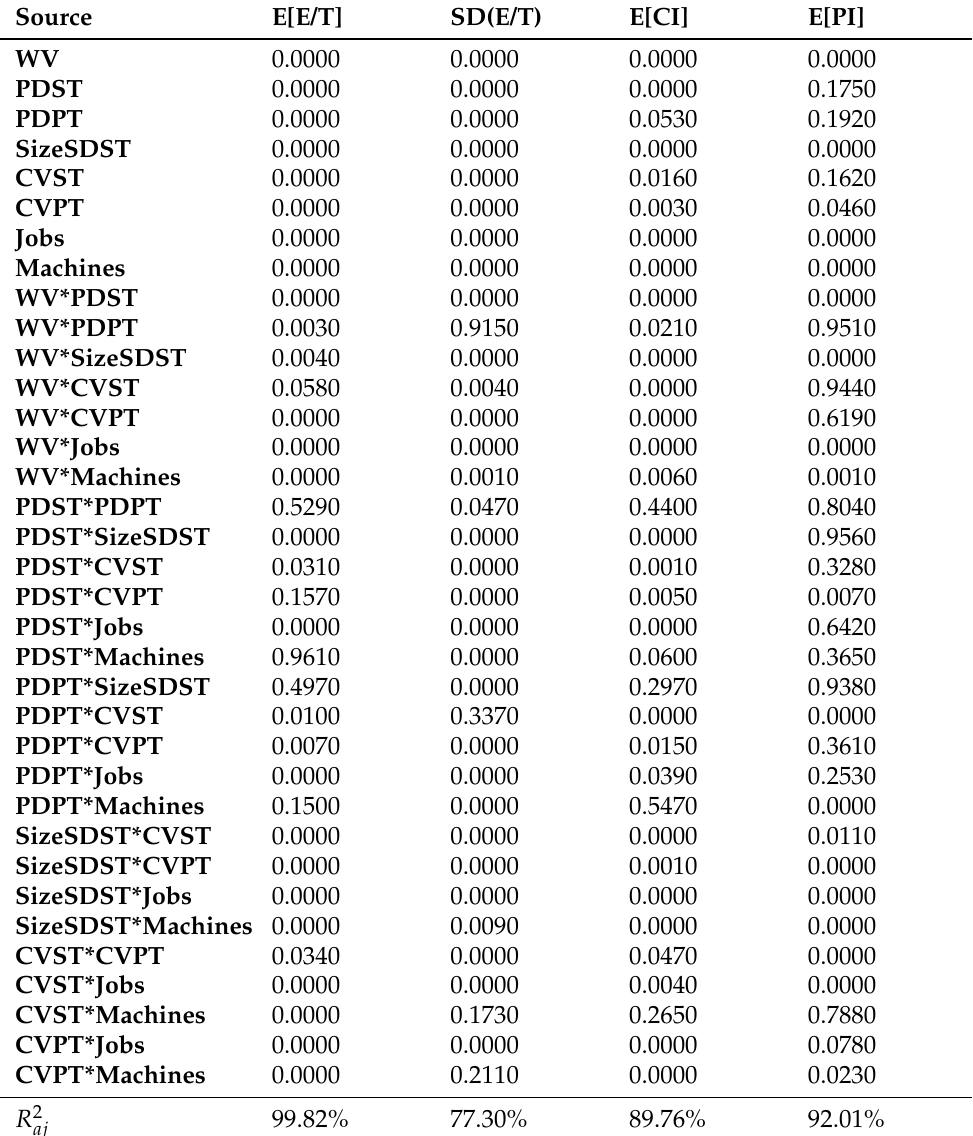
of the ANOVAs for each objective adj